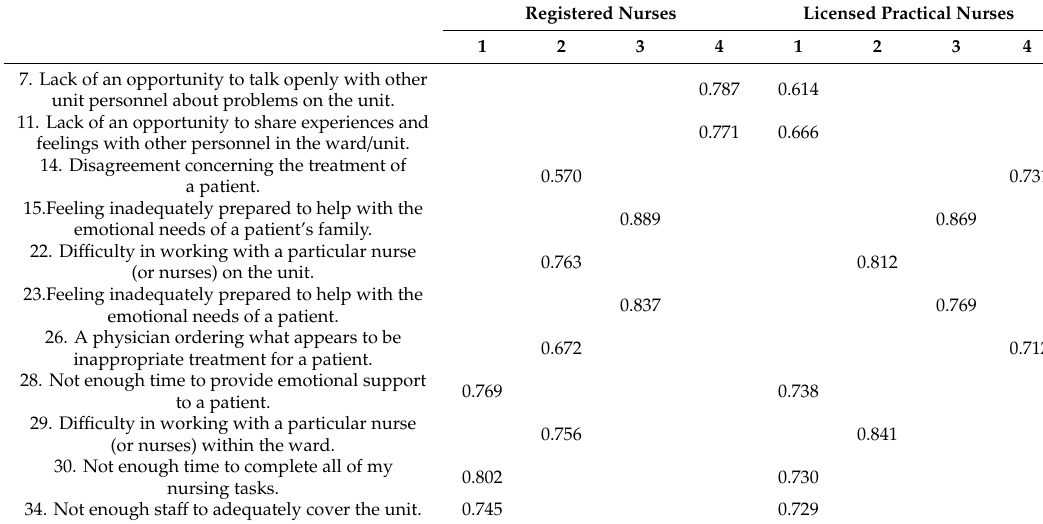
Table 3. Rotated component matrix of 11-item NSS for Registered Nurses and Licensed Practical Nurses.